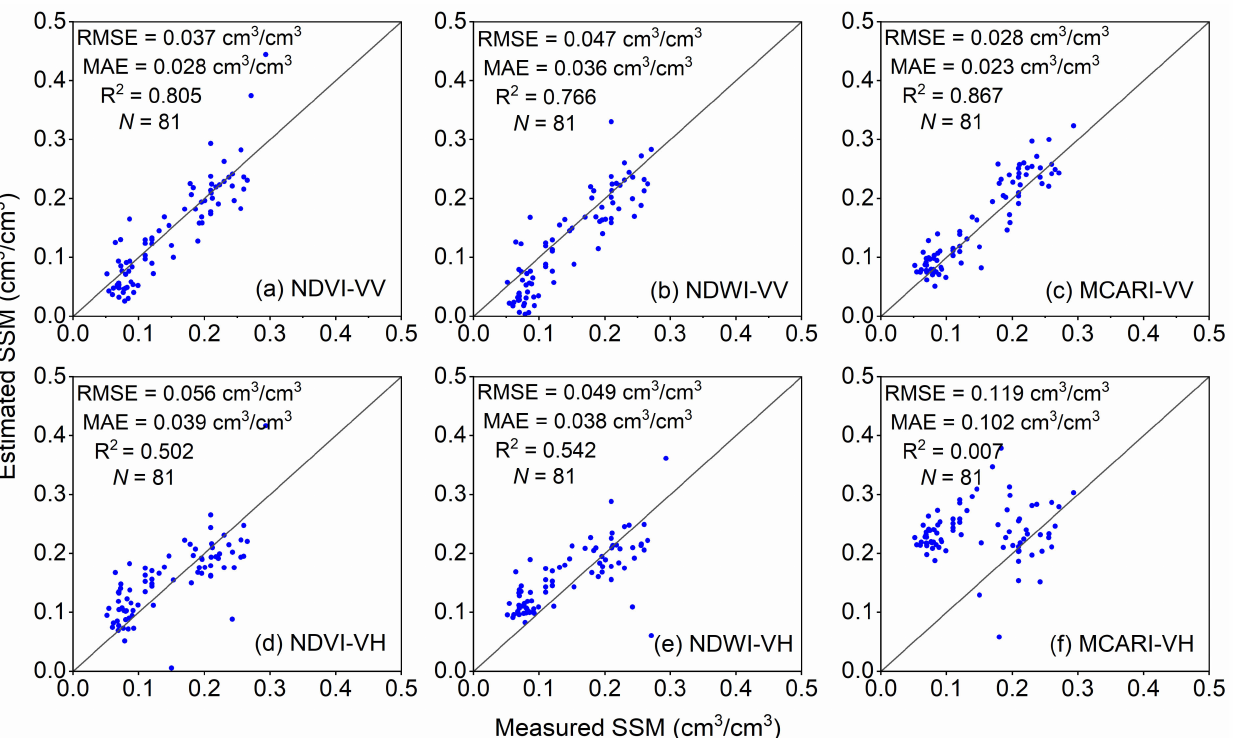
Figure 6. SSM validation under six